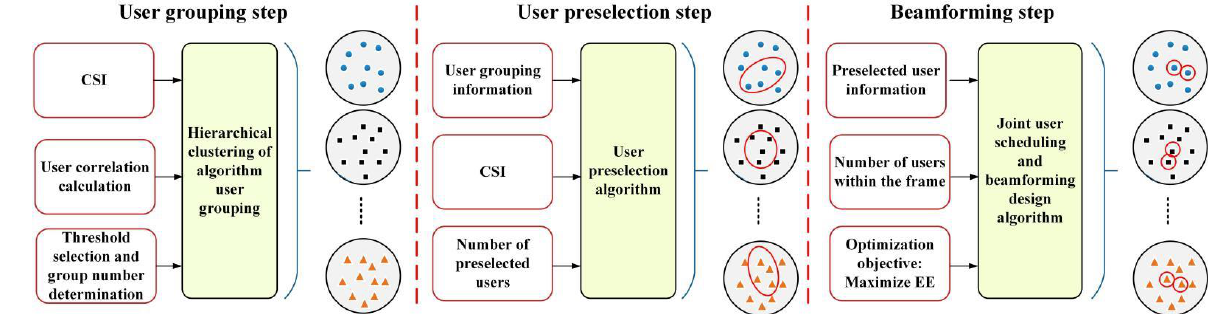
Figure 6. Design process of joint user scheduling and beamforming with the user preselection.